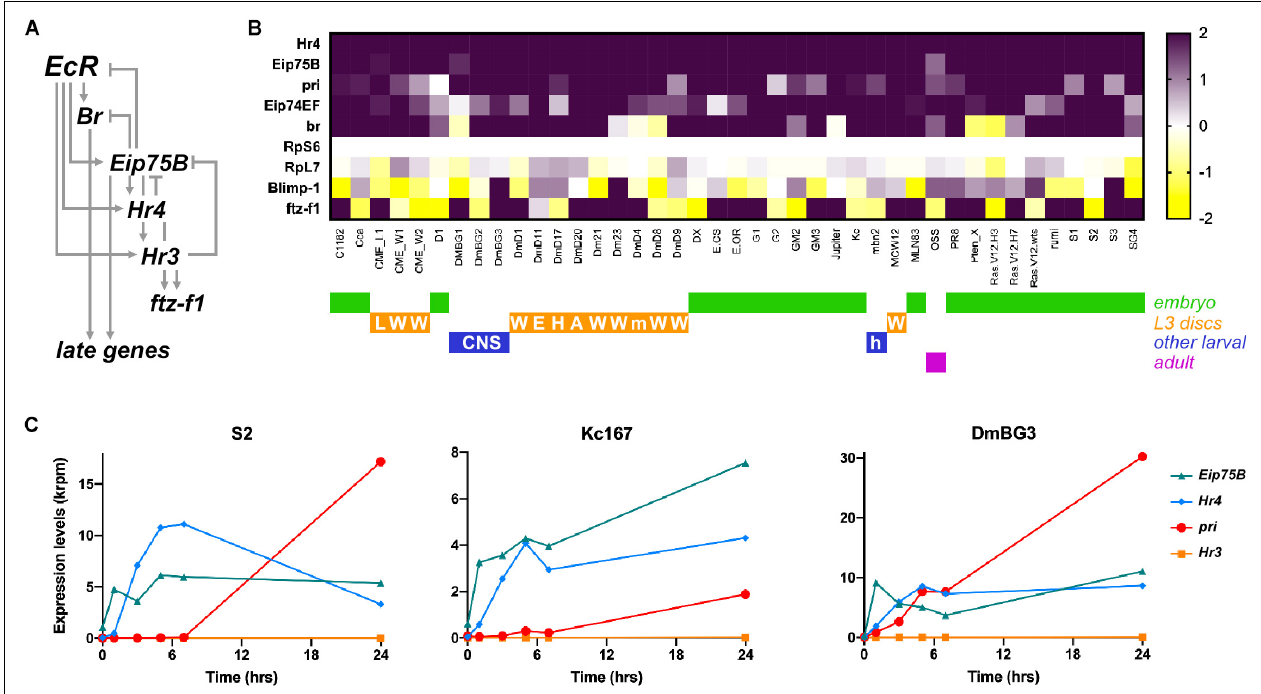
FIGURE 1 | pri expression is strongly induced in the response to ecdysone in Drosophila cell lines. (A) Scheme of the canonical temporal cascade of TFs induced by ecdysone at metamorphosis onset [adapted from Ou and King-Jones (2013)]. Upon activation by ecdysone, EcR activates the expression of early-acting TFs (Br, Eip75B), then EcR needs the activity of early TFs to trigger the expression of additional genes (Hr4, Hr3) mediating the response to ecdysone. (B) Heat map showing differential expression of genes (Log2FC) encoding ecdysone-response TFs (Hr4, Eip75B, Eip74EF, Br, Blimp-1, or ftz-f1) and pri in 41 Drosophila cell lines after vs. before 5 h of ecdysone treatment. RpS6 and RpL7 are used as control genes. Raw data from Ref. (Stoiber et al., 2016) were reprocessed to analyze pri expression, as well as of all Drosophila genes to allow direct comparison. The origin of every cell line is color coded. L, leg disk; W, wing disk; E, eye/antennal disk; H, haltere disk; m, mixed imaginal disks; A, antennal disk; h, hemolymph; CNS, central nervous system. (C) Time course expression of Eip75B , Hr4 , pri , and Hr3 after ecdysone addition in cultured S2, Kc167, and DmBG3 cells. Raw data are from Ref. (Stoiber et al.,